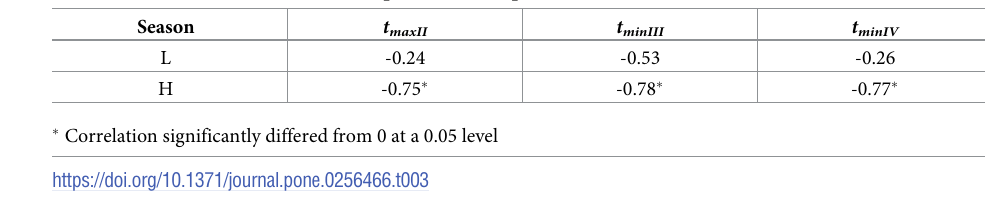
Table 3. Spearman’s coefficient of correlation between model predictors and season start for high concentration (H) and low concentration (L) of Betula pollen in atmospheric